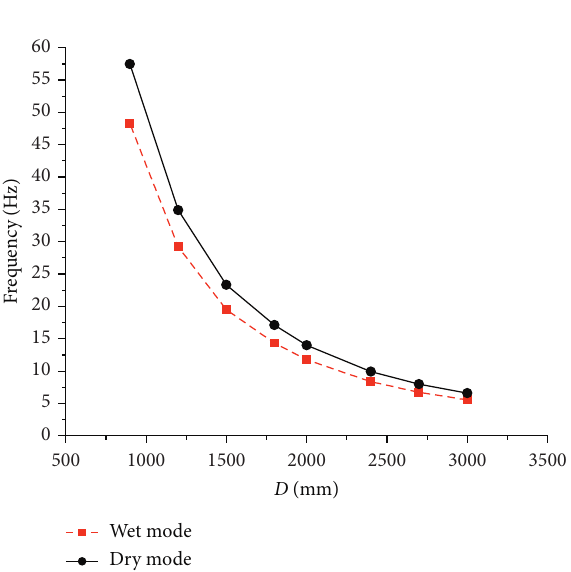
Figure 10: Comparison of the predicted first critical speeds with measured data [22].